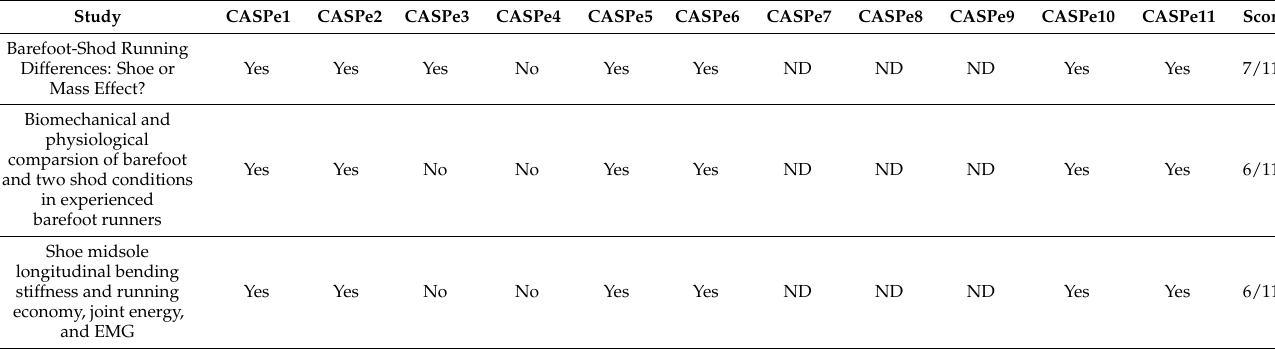
Table 7. Methodological Quality (observational studies). ND. Not